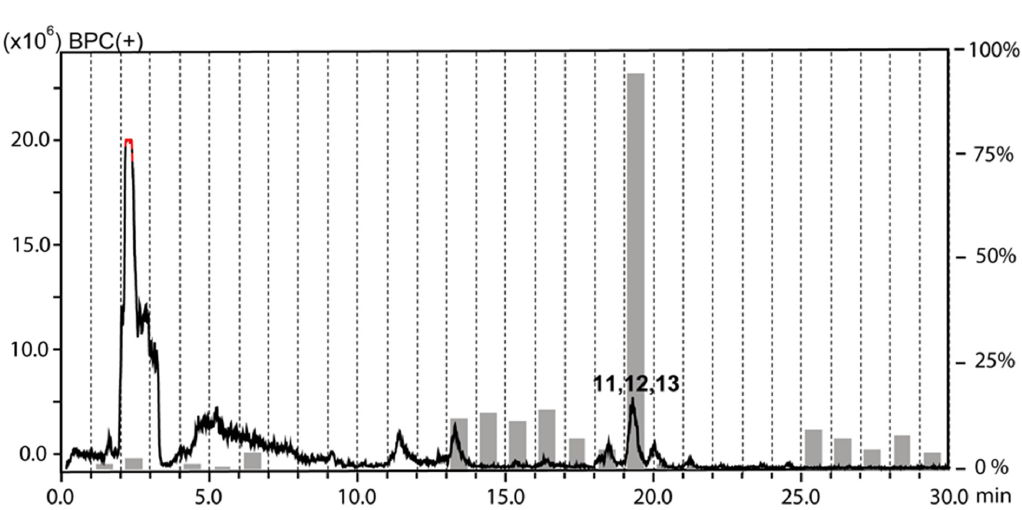
Figure 1. HPLC-based activity profiling of the chloroform fraction against axenic amastigotes of L. donovani. The ESIMS (base peak chromatogram in positive ion mode) from a separation of 300 µg of fraction is shown. For each microfraction the activity is expressed as percent growth inhibition in comparison to untreated cultures (grey bars). Bold numbers in the chromatogram refer to compounds 1 , 2 , and 5 – 10 .